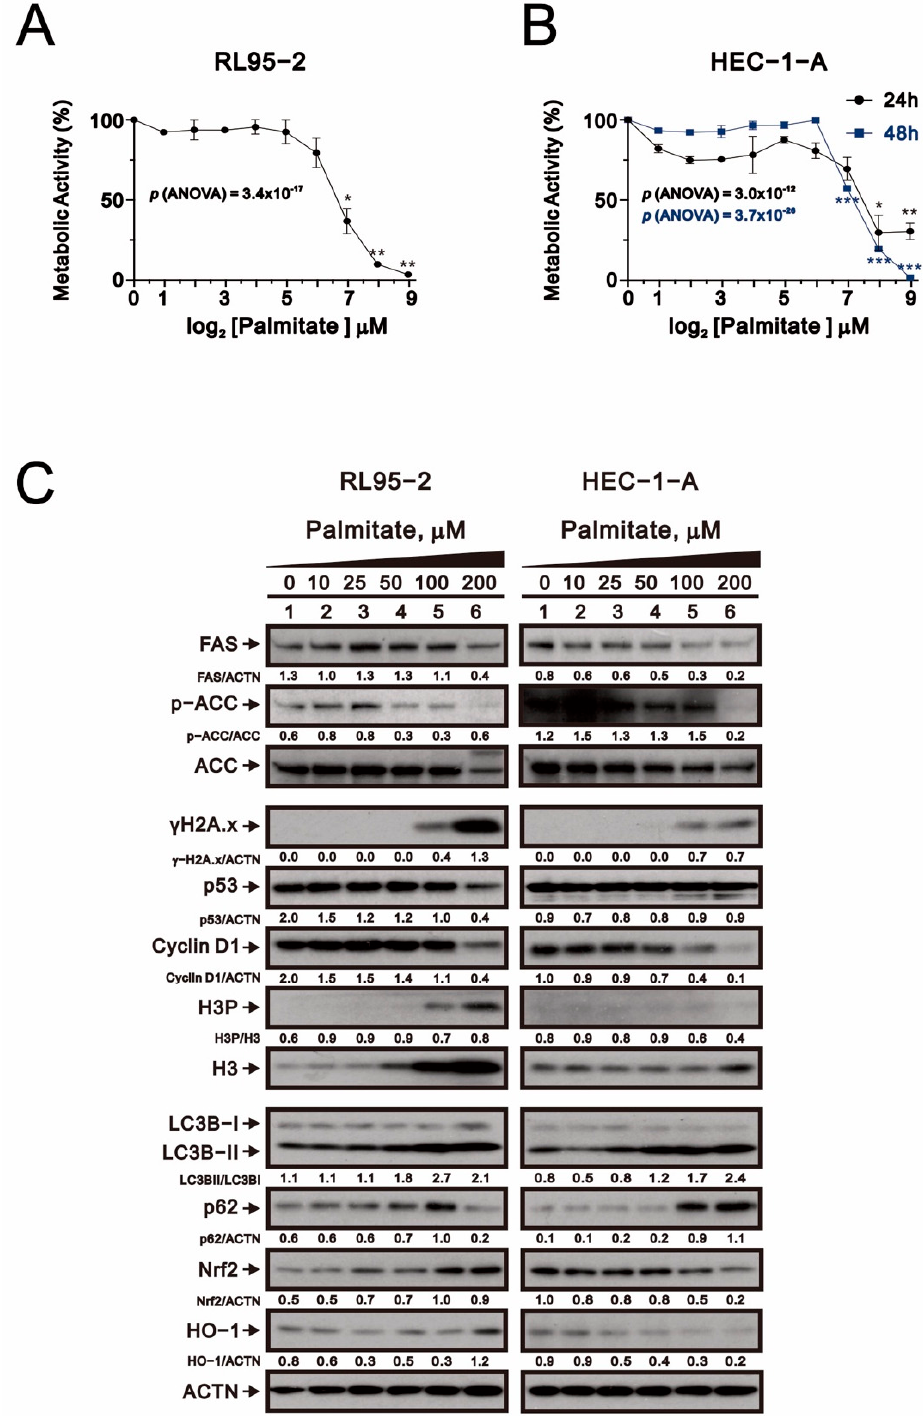
Figure 1. Responsiveness of human endometrial carcinoma cells to palmitate. ( A , B ) Metabolic activity measured using the MTT method. RL95-2, and HEC-1-A cells were treated for 24 h or 48 h with palmitate (0, 1.953125, 3.90625, 7.8125, 15.625, 31.25, 62.5, 125, 250, 500 µ M). Symbols depict the mean ± SD of three independent experiments. * p < 0.05, ** p < 0.01, and *** p < 0.001 (Student’s t -tests). ( C ) RL95-2, and HEC-1-A cells were treated for 24 h with indicated concentrations of palmitate. Cell lysates were subjected to Western blot analysis using antibodies against the indicated proteins. Alpha actinin (ACTN) was the loading control.